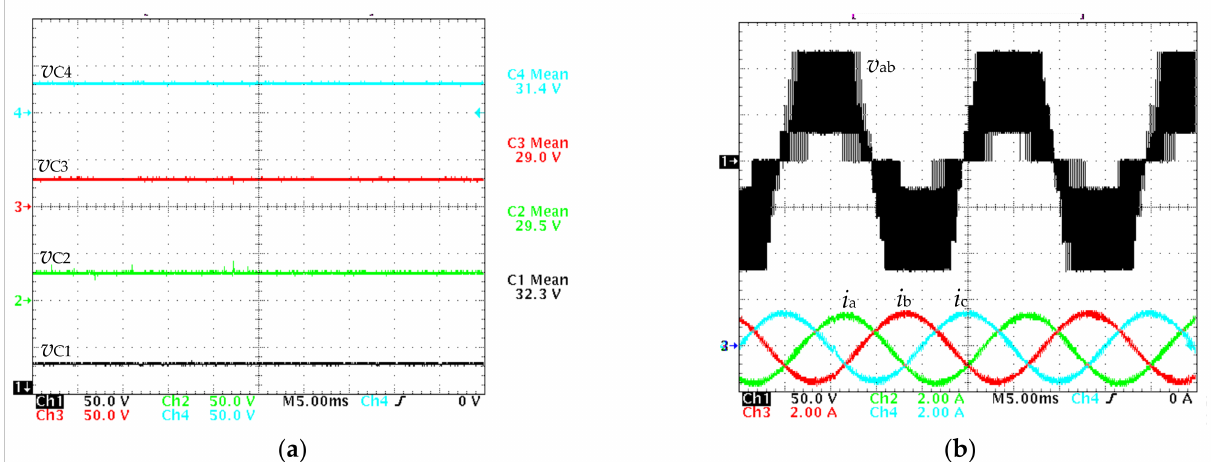
Figure 14. Experimental results of a five-level three-phase DC–AC converter operated with